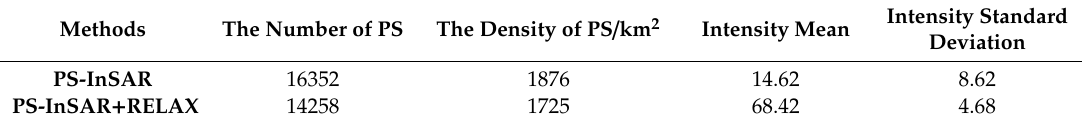
Figure 10. The identified PSs using ( a ) PS-InSAR technique and ( b ) PS-InSAR + RELAX in the experimental area A in Chaoyang CBD. The blue dots indicate the persistent scatterers displayed over the WorldView-2 image. Table 3. Statistical overview of the PS identification using PS-InSAR + RELAX and PS-InSAR techniques.